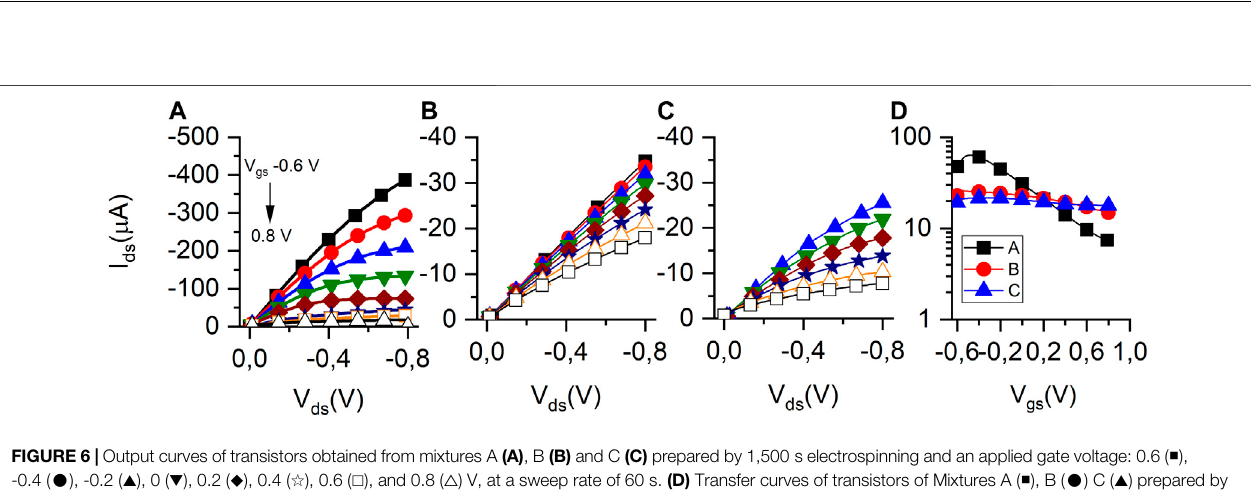
Frontiers in Physics |